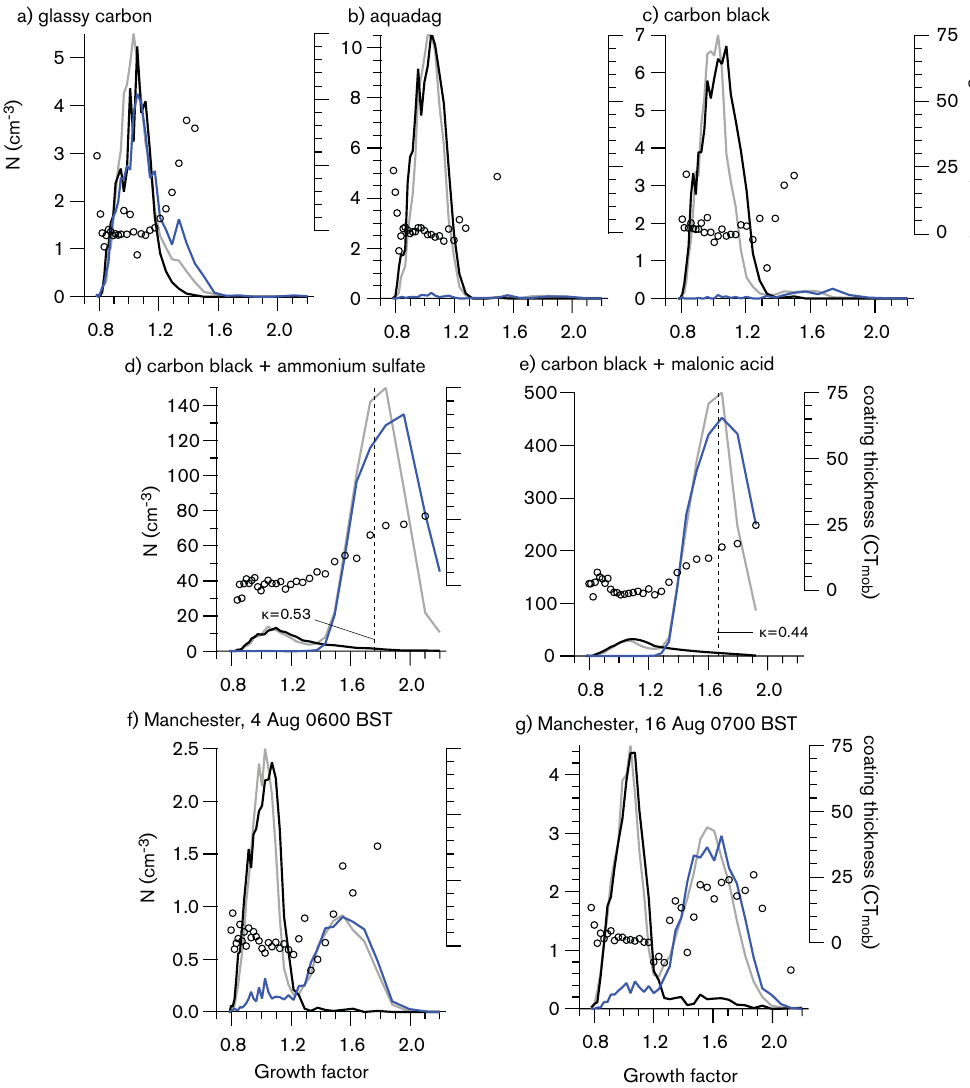
Fig. 3. Same as Fig. 2 but for different BC particle types and mixtures. All rBC mean diameter calculations assumed an rBC density of 1.42, equal to that of the glassy carbon calibration particles. rBC species shown are (a) glassy carbon spheres, (b) aquadag, (c) carbon black, (d) mixture of ammonium sulfate and carbon black, (e) mixture of malonic acid and carbon black, and (f) and (g) show two example scans measured for ambient Manchester air outside the laboratory for the mornings of 4 and 16 August 2010. Dashed vertical lines give expected growth factors for pure ammonium sulfate and malonic acid. Fig. 5. The two backward trajectories arriving on 3 and 7 August show typical flow patterns during the early por- tion of ambient measurements that featured frequent frontal passages and westerly flow. The flow pattern changes around 14 August when flow over the northern UK was influenced by the high pressure system and became easterly, as shown by the trajectories for 14 and 16 August. The backward trajectory for 12:00 UTC on 8 August shows a stronger northerly component compared to other trajectories during the westerly